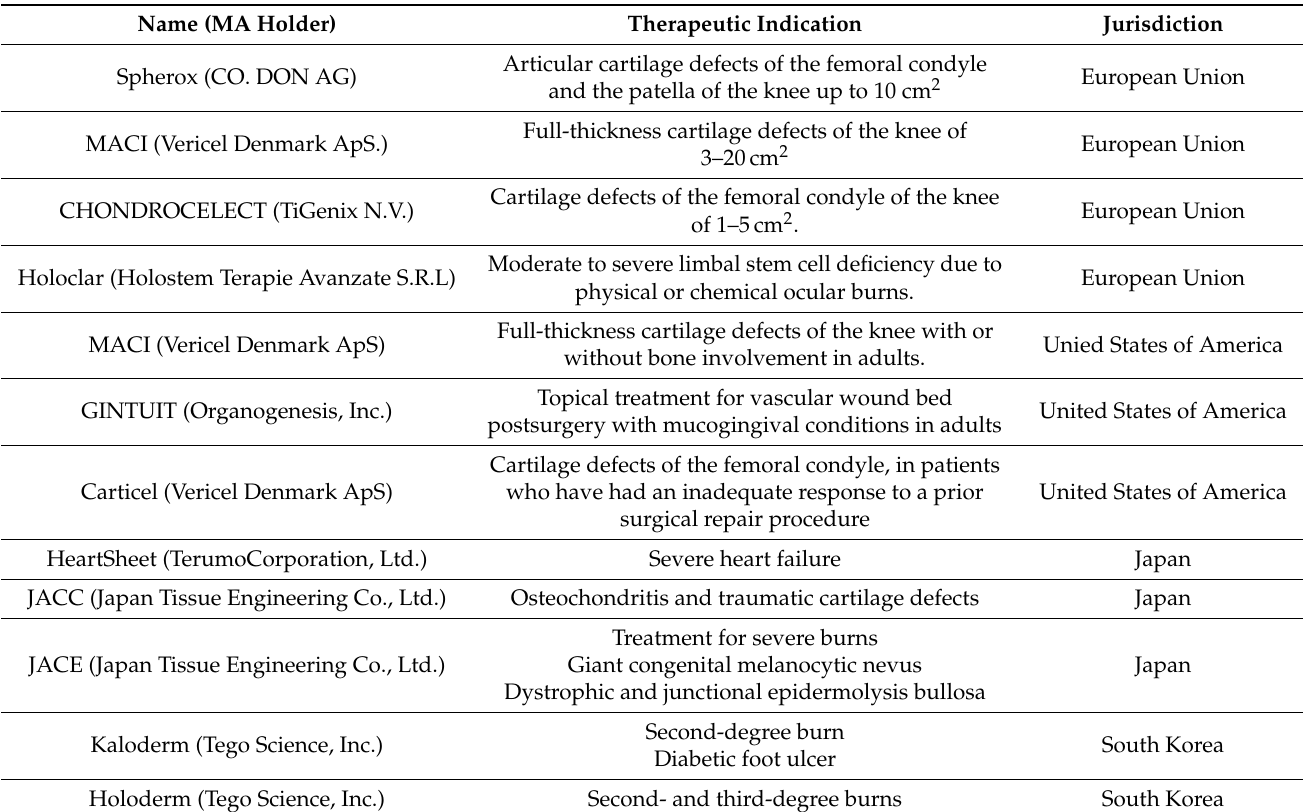
Table 5. Tissue-based products authorized